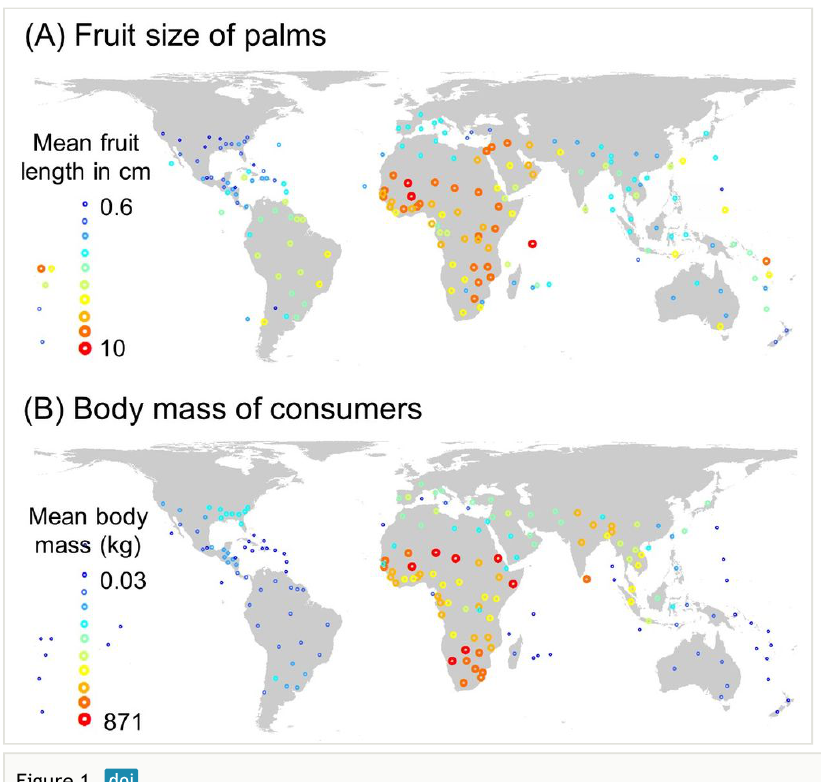
Figure 1. Global functional trait distributions of palms ( n = 2469) and frugivorous consumers ( n = 3835, incl. birds and mammals), showing large-scale co-variation between (a) palm fruit size (length in cm) and (b) consumer body size (mass in kg). Symbols are plotted for the mass centroids of geographic units ('botanical countries', TDWG level 3 units) and represent mean values across all species in a given unit. Values are calculated across a total of 29,032 species-level occurrences (5,218 for palms, 23,814 for